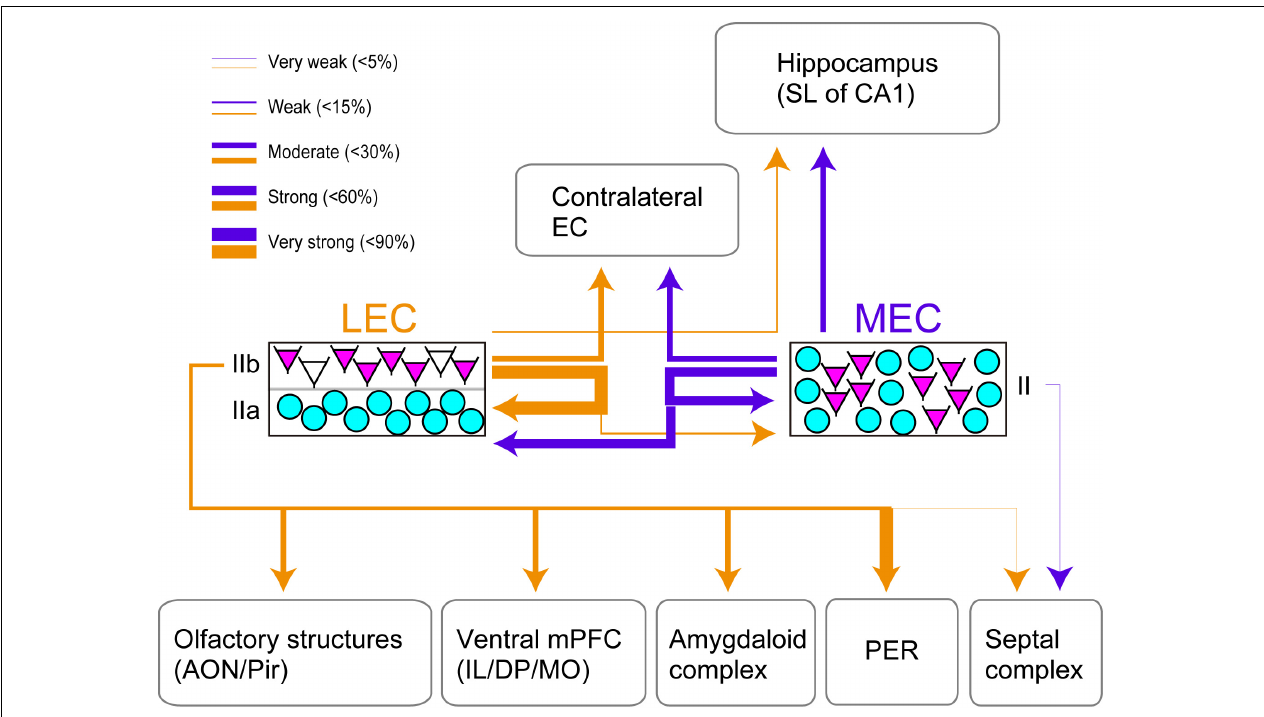
FIGURE 4 | Summary of the projection of CB+ neurons in LEC and MEC. EC Layer II neurons which comprise CB+ neurons (magenta) and RE+ neurons (cyan) are shown. The arrows indicate the projections originating from the LEC CB+ neurons (yellow) and the MEC CB+ neurons (purple). Note that the arrows do not show the laminar targets of the ipsi- and contralateral EC projections. The thickness of the lines is based on the percentage of double-labeled neurons/CB+ neurons. Note that although the projection from LEC CB+ cells to PER seems strong, this projection originates only from a restricted very dorsal portion of